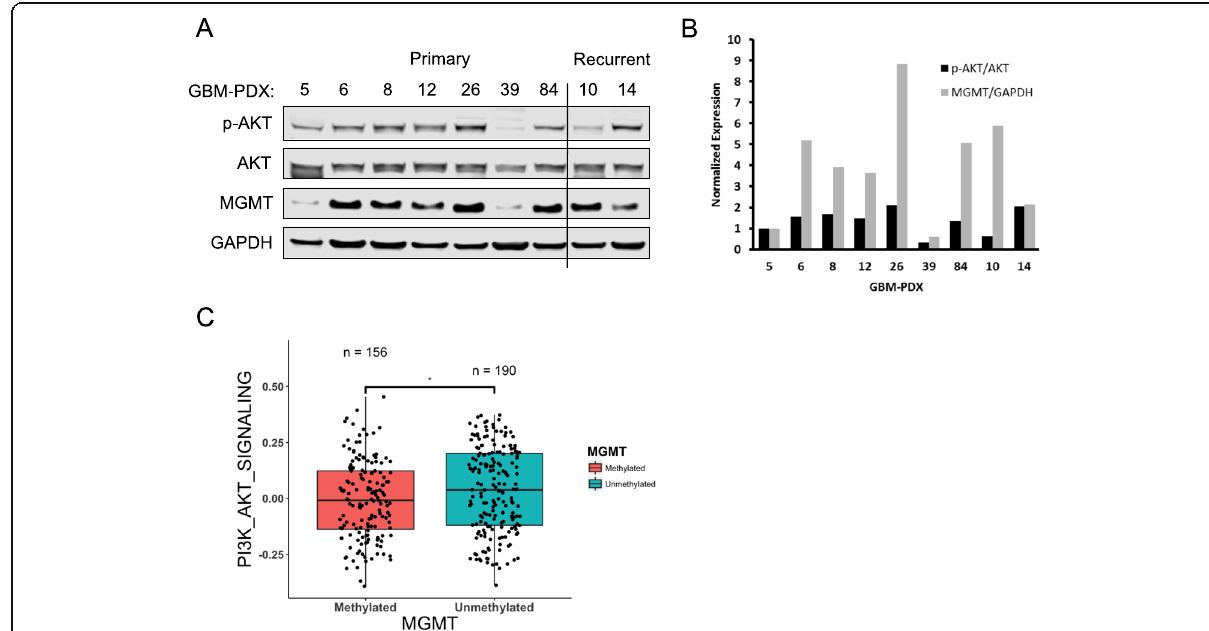
Fig. 3 MGMT expression correlates with PI3K-AKT pathway activation. a Total protein from parental GBM-PDX subcutaneous tumor lysates was used to assess the differential expression of MGMT and relative activation of p-AKT between the samples. b Densitometry was used to quantify the western blot results and all PDX tumors were normalized to GBM5. c Gene set variation analysis (GSVA) was used to determine gene set enrichment scores of the PI3K-AKT signaling pathway according to the methylation status of the MGMT promoter in clinical samples